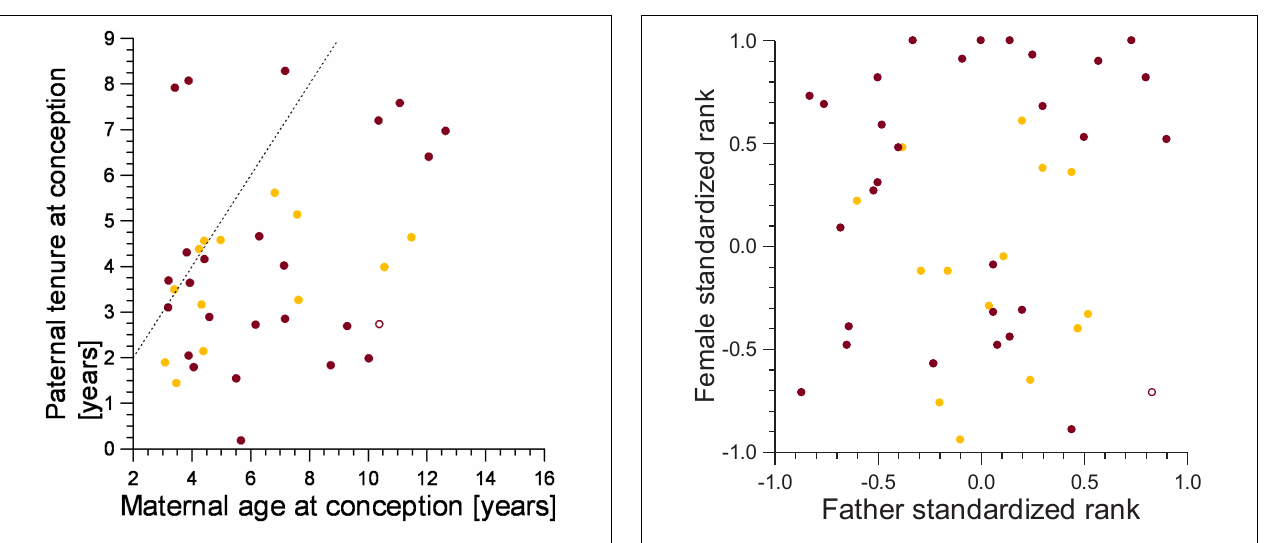
FIGURE 7 | The standardized rank of mothers of cubs lost to violent attacks (burgundy) and maternal neglect (amber) in relation to the standardized rank of their fathers at conception of the victim. Filled symbol: immigrant males, open symbol: natal male. offspring of the perpetrator when it killed the victim. There was not a single case in which the victim of infanticide and the offspring of the female perpetrator shared a